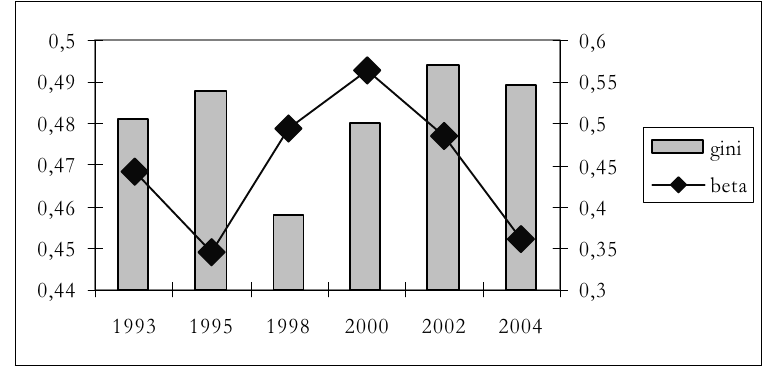
Figure 4 – Dagum model for human capital in Italy from 1993 to 2004, Gini index and 2